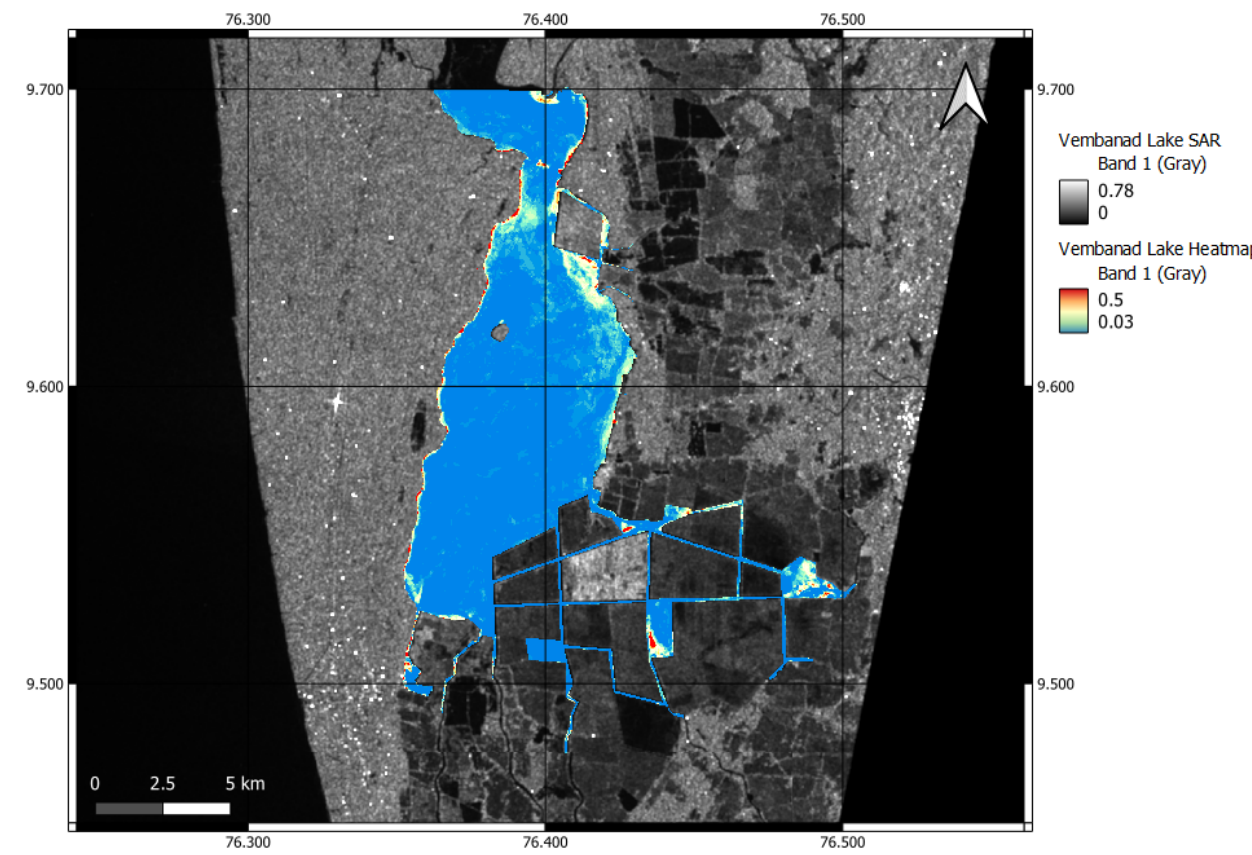
Figure 17. Heatmap of water hyacinth infestations on Vembanad Lake from 12 January 2019 to 1 January 2021 (46 total acquisitions). Background SAR image acquired 12 January 2019 (Sentinel-1, Credits:ESA). Blue = low concentration–Red = high